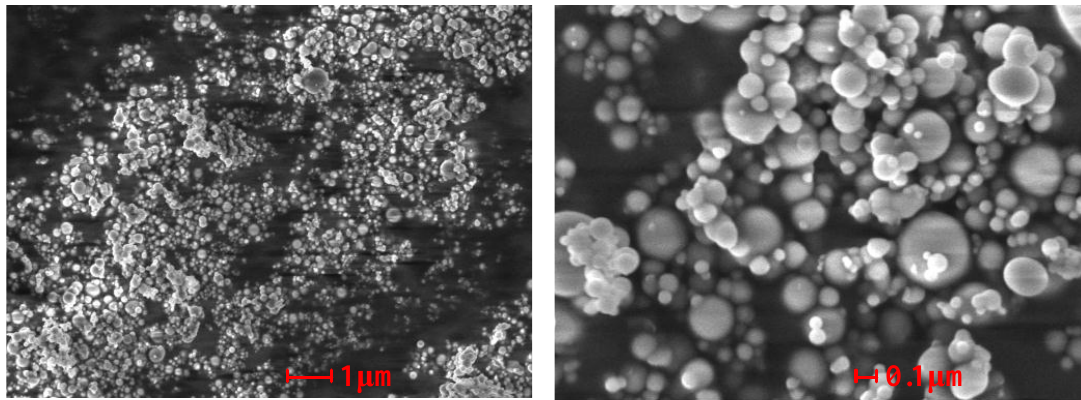
Figure 9. SEM photographs of the cross-sectional structures of Sample